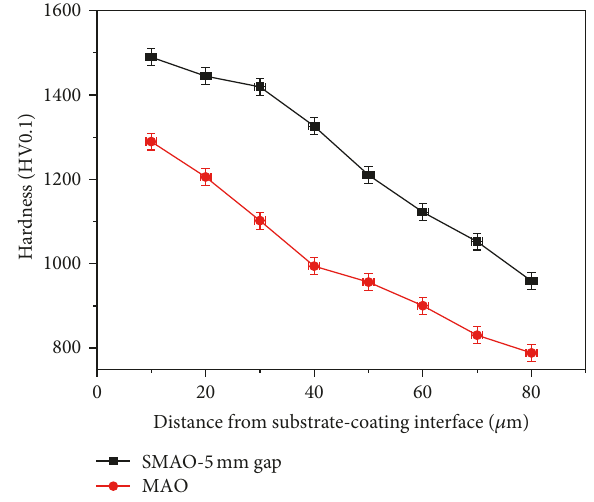
Figure 11: Vickers hardness profiles of SMAO and MAO deposits.